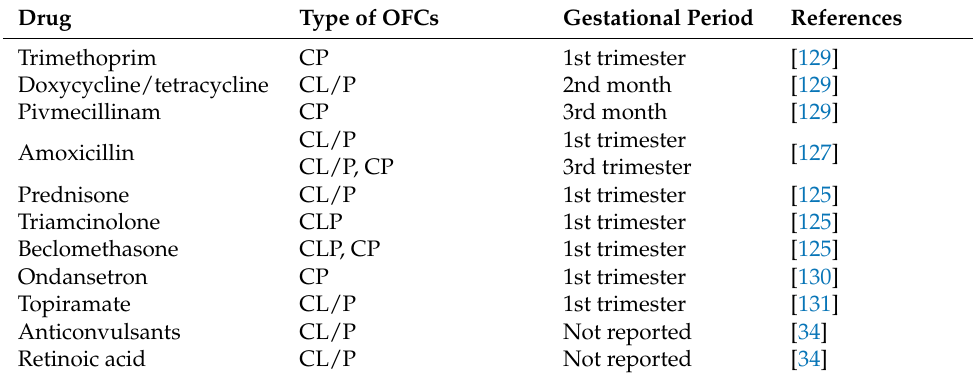
Table 2. Licit drugs taken in pregnancy associated with specific type of OFCs [CP: cleft palate; CL/P cleft lip with or without palate; CPL: cleft lip and palate, OFCs: orofacial clefts]. Drug Type of OFCs Gestational